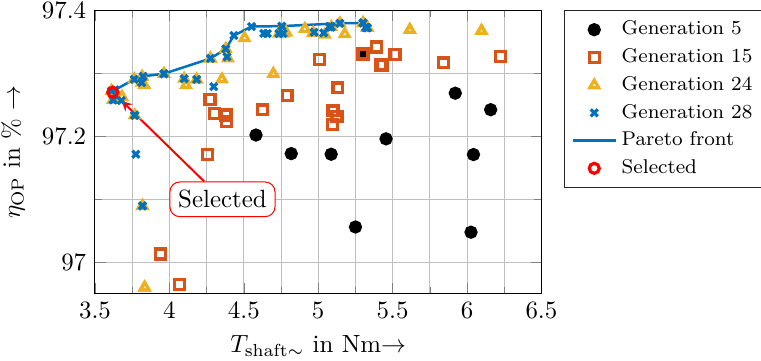
Figure 9. Optimization results; selected geometry for prototype is highlighted.